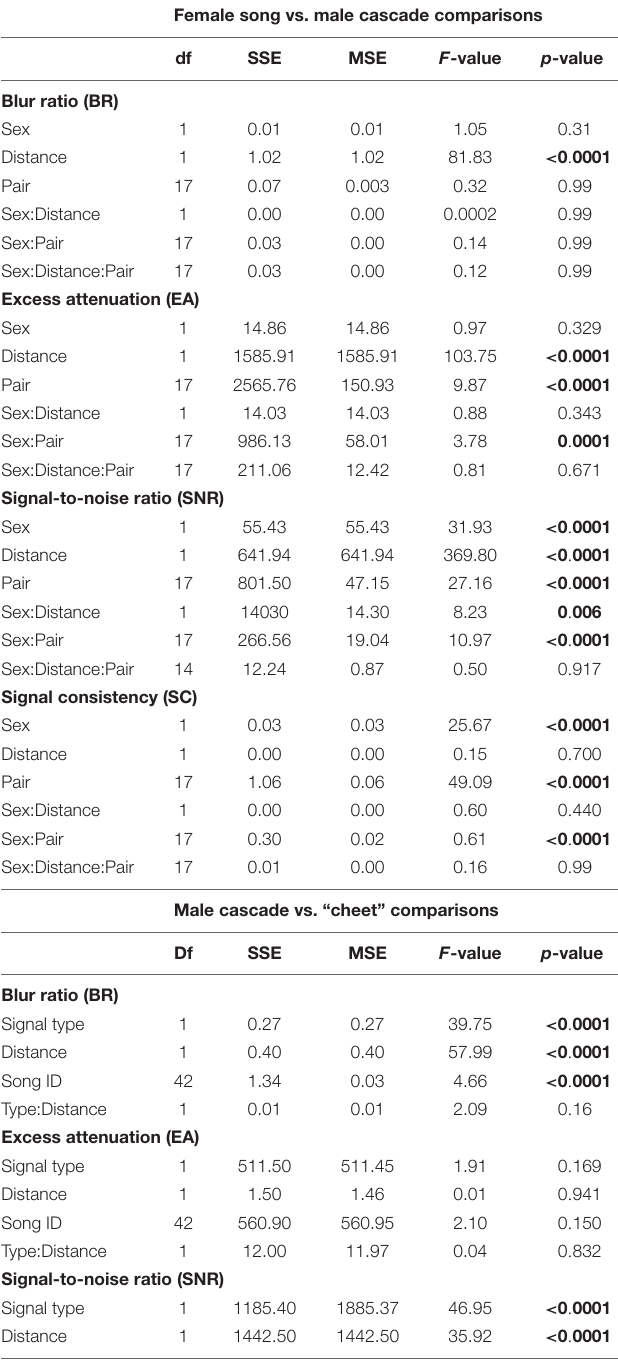
TABLE 1 | ANOVA output for sex-based and within-male canyon wren song transmission comparisons of Blur Ratio (BR), Excess Attenuation (EA), Signal-to-noise Ratio (SNR), and Signal Consistency (SC)